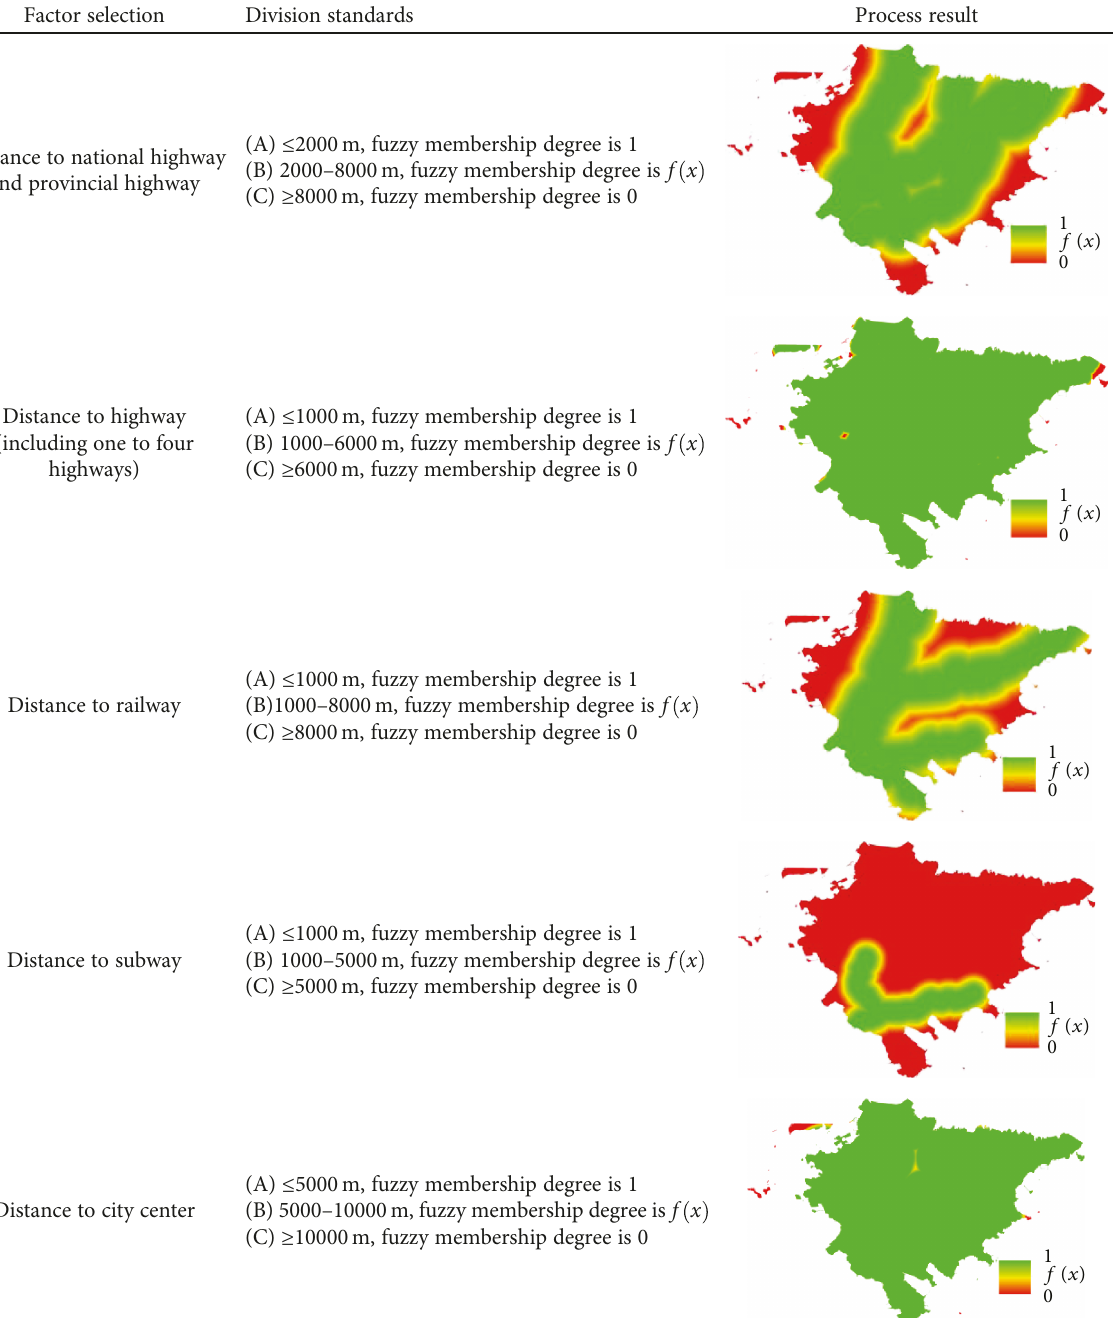
Table 5: Selection and processing of social